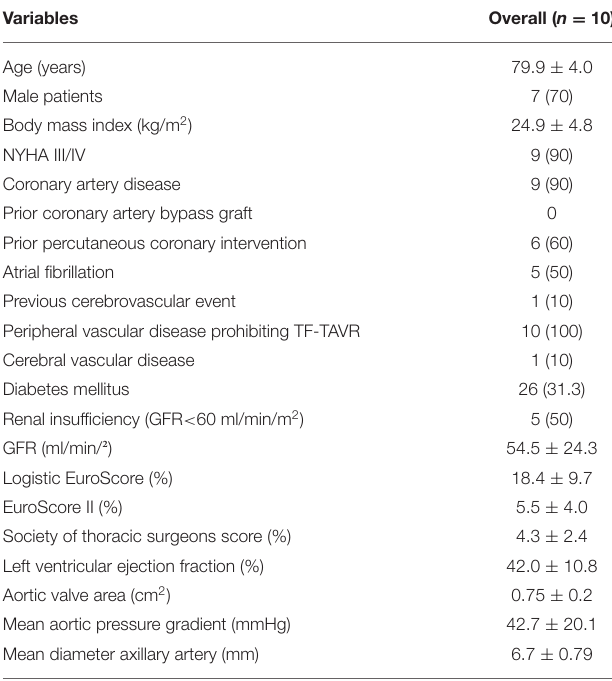
TABLE 1 | Baseline characteristics of the study